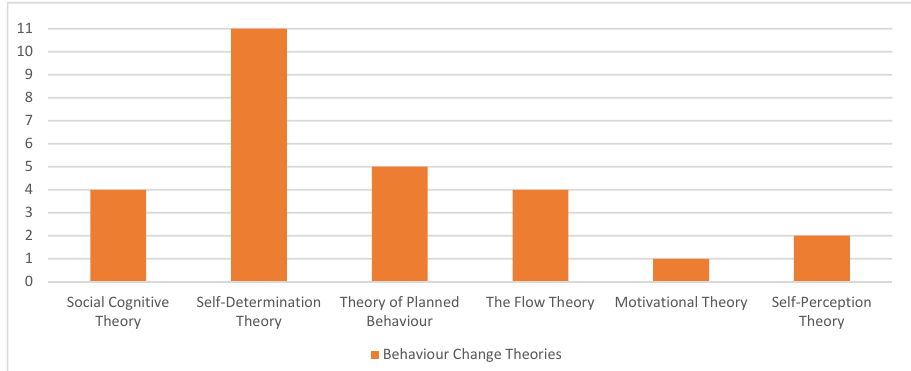
Figure 8. Frequency of behaviour change theories in the Psychology domain.